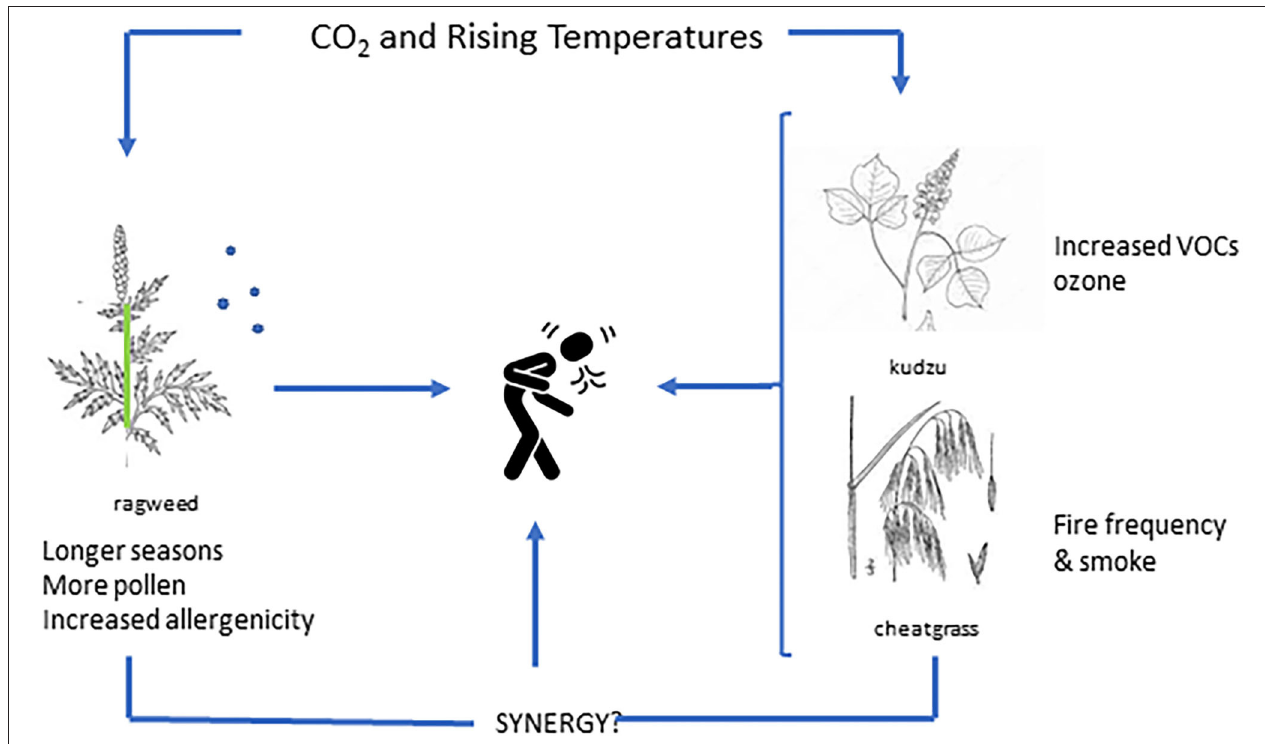
FIGURE 1 | Illustration of individual and synergistic impacts related to plant based aeroallergens in the context of rising levels of carbon dioxide and/or temperature.